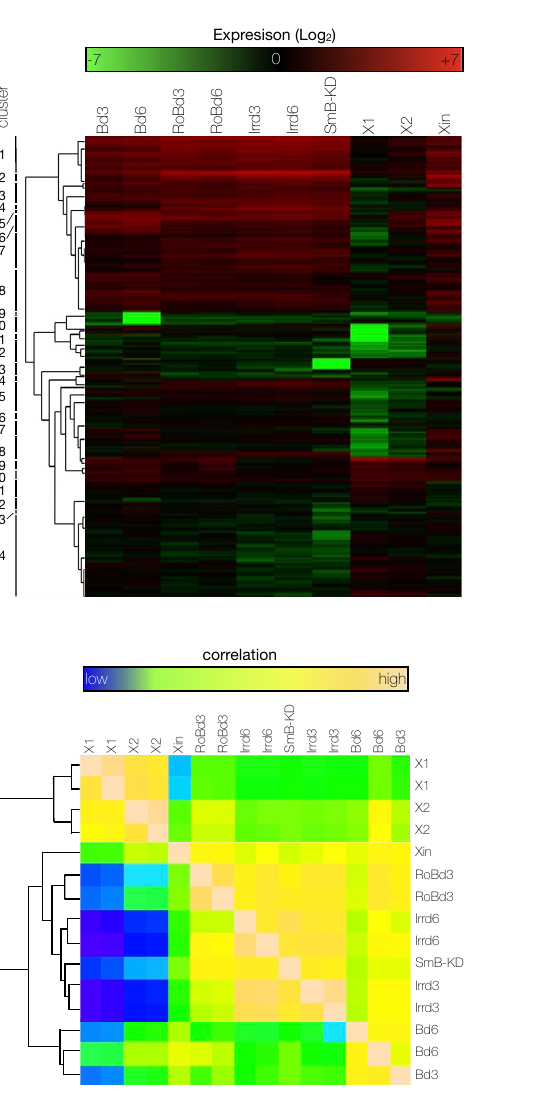
Figure 4. Sorting of the RNA-seq data. ( A ) A heat map was populated with 3586 genes that were sorted based on the differential expression among the samples, as explained in Figure 3. ( B ) The Pearson’s correlation based on the shortlist of 3586 genes showed how the samples analyzed in this study correlate expression-wise. Two main clusters of samples are visible: one that is stem cell-enriched (X1, X2 samples) and one that is non-stem cell-enriched (Xin, RoB, Irr d3, Irr d6, SmB (RNAi), blastema samples). Within the non-stem cell-enriched samples, the blastema samples clustered together in a sub-group (second most relevant hierarchical division). ( C – E ) The 3586 genes were grouped according to their molecular function ( C ). A lower hierarchical level of molecular functions was showed by the different classes of genes with binding activity ( D ). The pie chart showed how the 111 genes with nucleic acid binding activity distribute in the two main classes of nucleic acid binding: DNA- and RNA-binding ( E ).